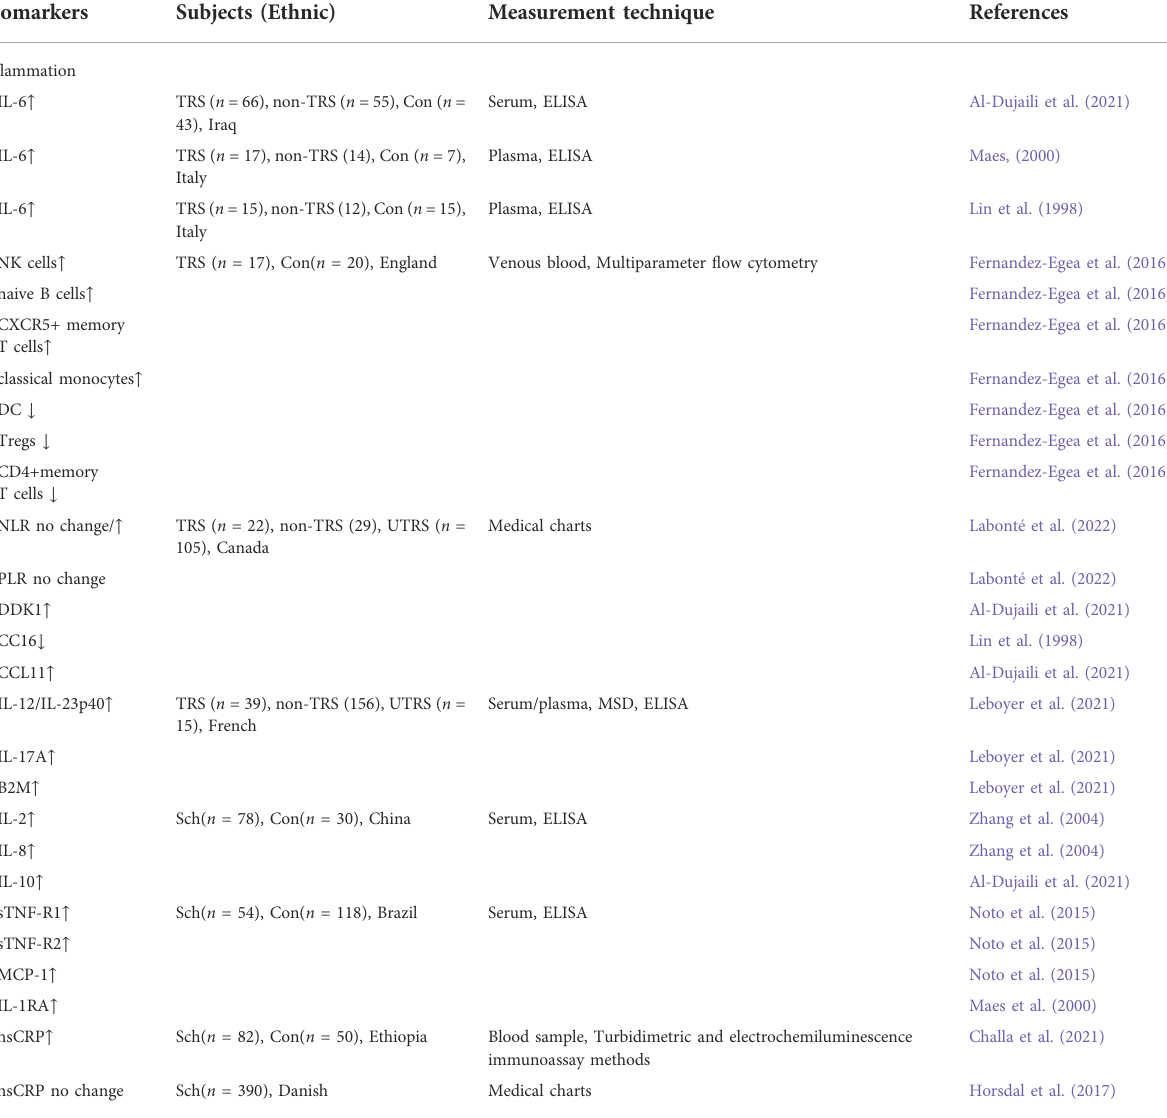
TABLE 2 In fl ammation and stress biomarkers of treatment resistant